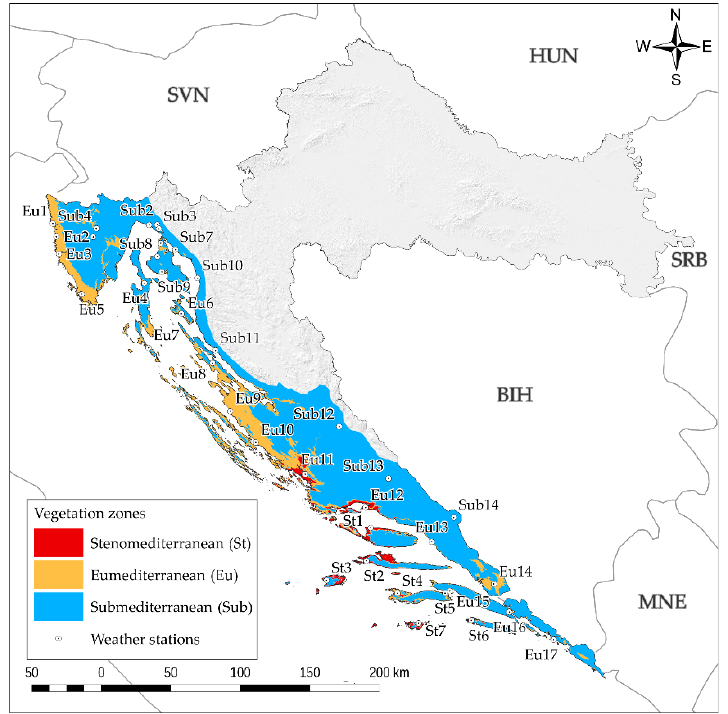
Figure 2. Spatial distribution of vegetation zones according to the results of logistic regression of climatic elements and altitude.